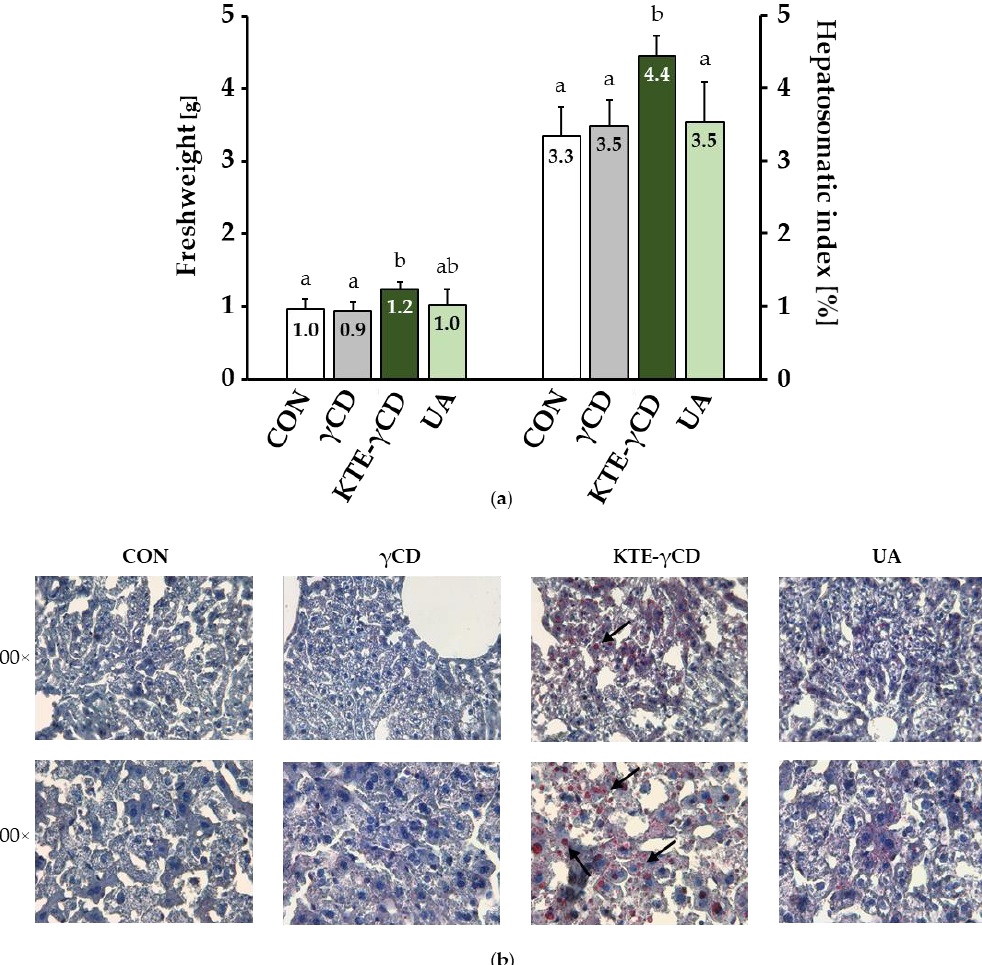
Figure 3. Kuding tea extract- γ -cyclodextrin (KTE- γ CD) increased liver weight and hepatic fat accumulation. Mice were fed (ad libitum) the following diets for 6 weeks: high-fat, high-fructose, Western-type diet (CON, control), 12.88% γ CD, 7.12% KTE encapsulated in 12.88% γ CD (KTE- γ CD) or 0.15% UA (UA). ( a ) The absolute liver weight and hepatosomatic index (liver weight / total body weight) were significantly increased in KTE- γ CD-mice. Data are expressed as the mean + SD ( n = 8–10 mice / diet). Statistical analyses of liver weight and hepatosomatic index were performed using one-way ANOVA. Di ff erent letters indicate statistically significant di ff erences between treatments ( p ≤ 0.05). ( b ) Representative liver histologic sections stained with Oil Red O (ORO) and haemalaun. Fat droplets in liver cells were stained red (arrows), and the nuclei were stained blue. Liver samples were visualized with a light microscope (magnification 200 × and 400 ×